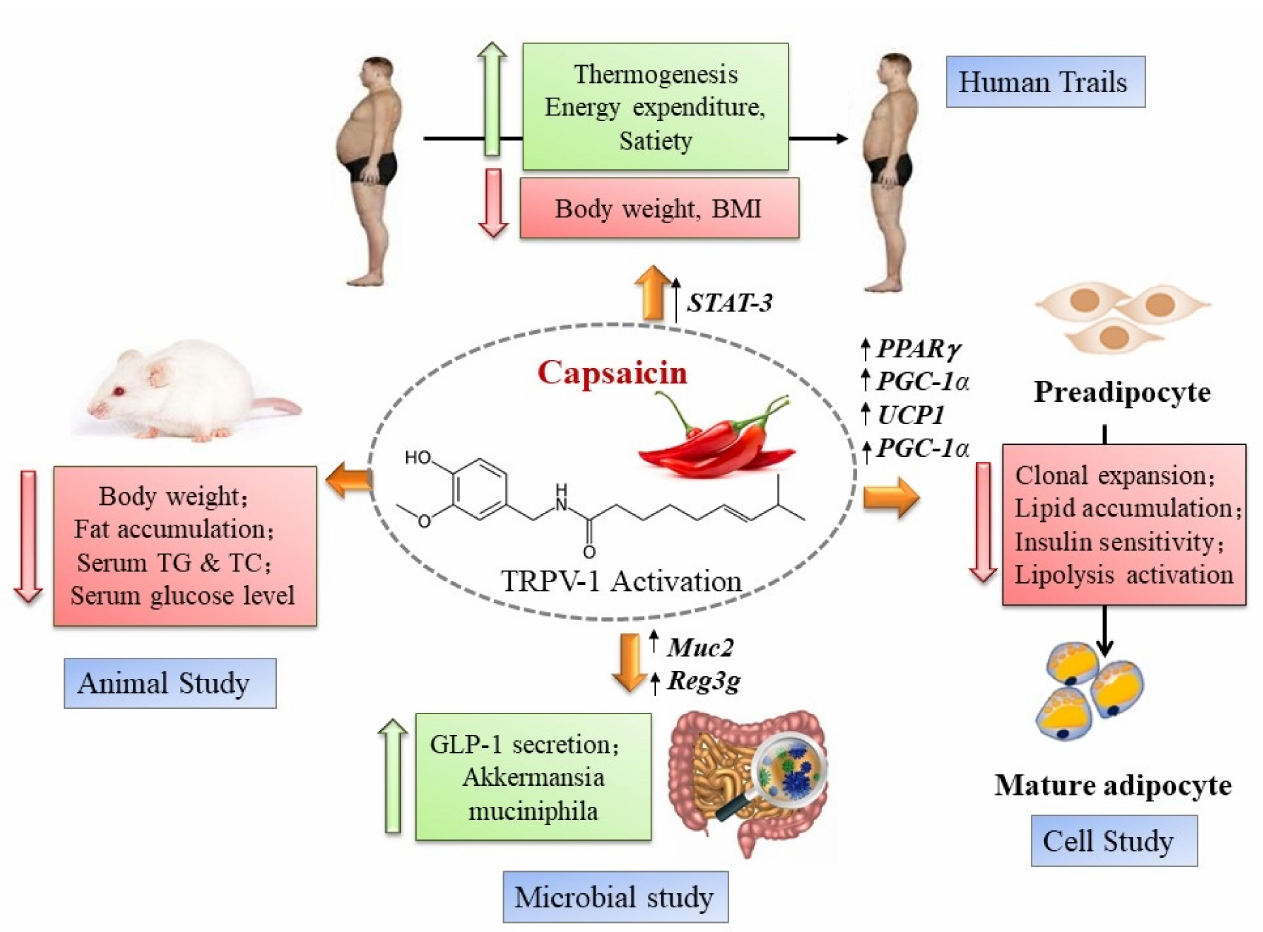
Figure 1. The complex molecular mechanism of action by which capsaicin may prevent the devel- opment of metabolic syndrome. In humans, TRPV1 activation may up-regulate Signal Transducer and Activator of Transcription-3 (STAT-3), a key member of the JAK/STAT pathway. Stimulation by cytokines of STAT-3 expressed in hepatocytes prevents steatosis. In animal studies, TRPV1 activation was linked to reduced fat accumulation and improved serum triglyceride (TG) and total cholesterol (TC) levels. Dietary capsaicin stimulates glucagon-like peptide-1 (GLP-1) secretion in the gastrointesti- nal tract. Furthermore, capsaicin supports the growth of the “anti-obesity bacterium”, Akkermansia muciniphila , by increasing mucin production, acting on the mucin-2 ( Muc2 ) gene Activation of TRPV1 in preadipocytes results in lipid accumulation and increased insulin sensitivity via up-regulation of the Peroxisome Proliferator-Activated Receptor- γ ( PPAR γ ), PPAR γ -coactivator-1 α ( PGC-1 α ), and Uncoupling Protein-1 ( UCP1 ) genes. Reproduced with permission from